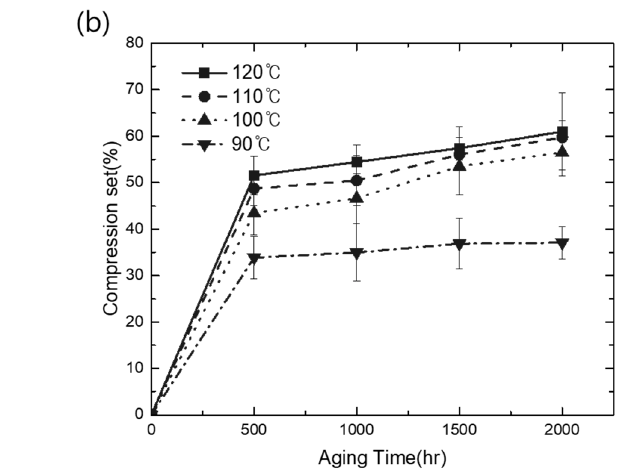
Figure 1. Comparison of tensile thermal oxidation aging results: ( a ) tensile strength changes of EPDM; ( b ) tensile strength changes of TPV.